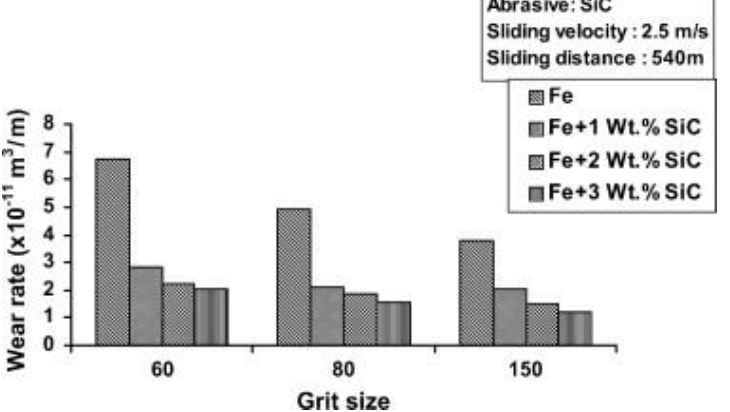
Figure 10. Wear rate of iron and iron-SiC composites. Reproduced from [53], with permission from Elsevier, 2009.